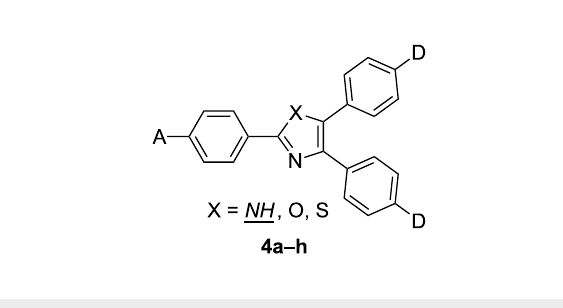
Figure 3: Donor–acceptor triaryl push–pull azoles 4a – h